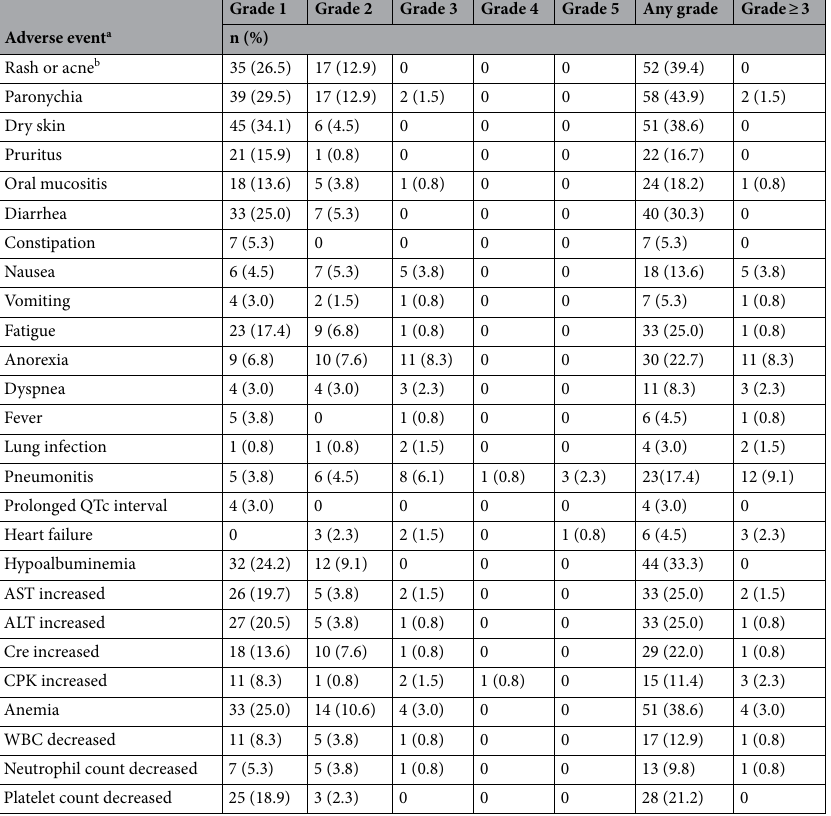
Table 4. Adverse events during osimertinib treatment (n = 132). ALT alanine aminotransferase, AST aspartate aminotransferase, CPK creatine phosphokinase, Cre creatinine, WBC white blood cell. a Adverse events were graded using the National Cancer Institute Common Terminology Criteria for Adverse Events, version 5.0. b This category represents a grouped term for the